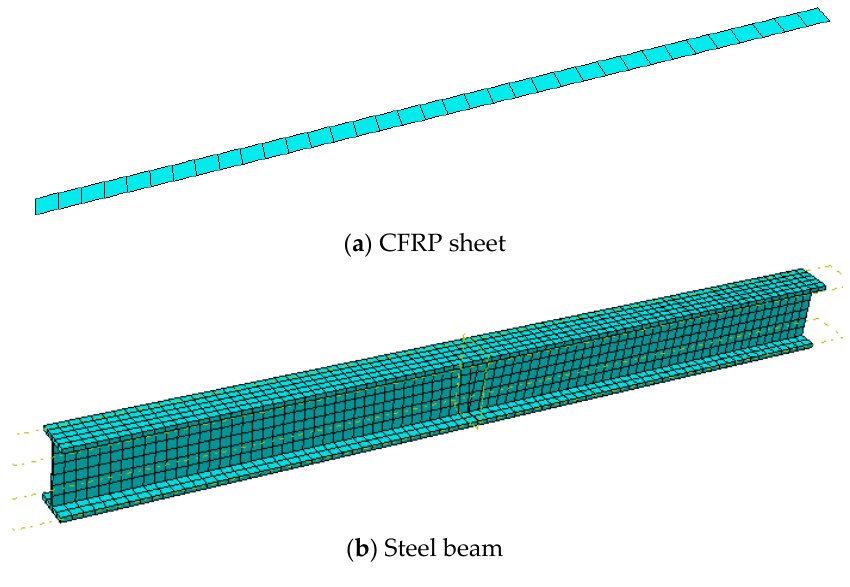
Figure 4. Element division.